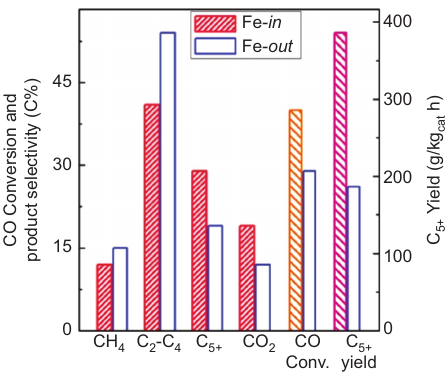
Figure 7 The effect of confinement in CNTs on the activity of FTS iron catalyst (Reprinted with permission from ref [132]. Copyright (2011) American Chemical